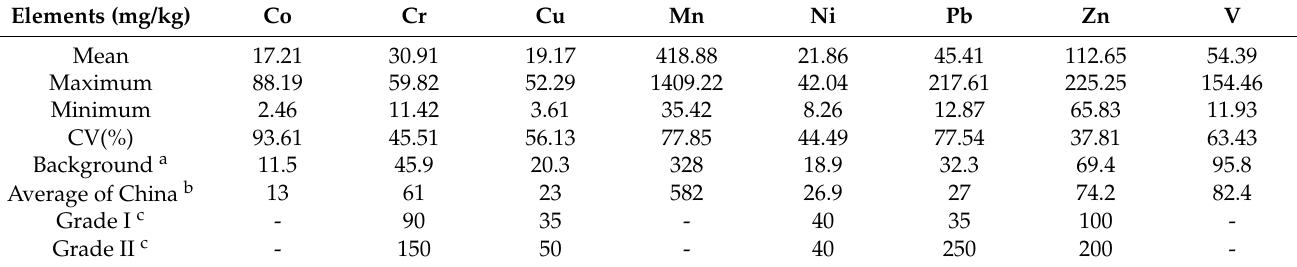
Table 1. Descriptive statistics of potentially toxic-element concentrations